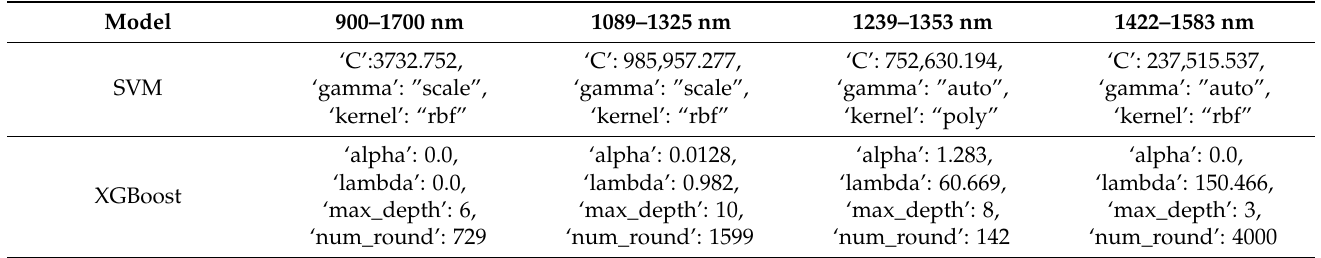
Table 5. Hyperparameters selected for the ML methods by applying the Bayesian optimization method. Model